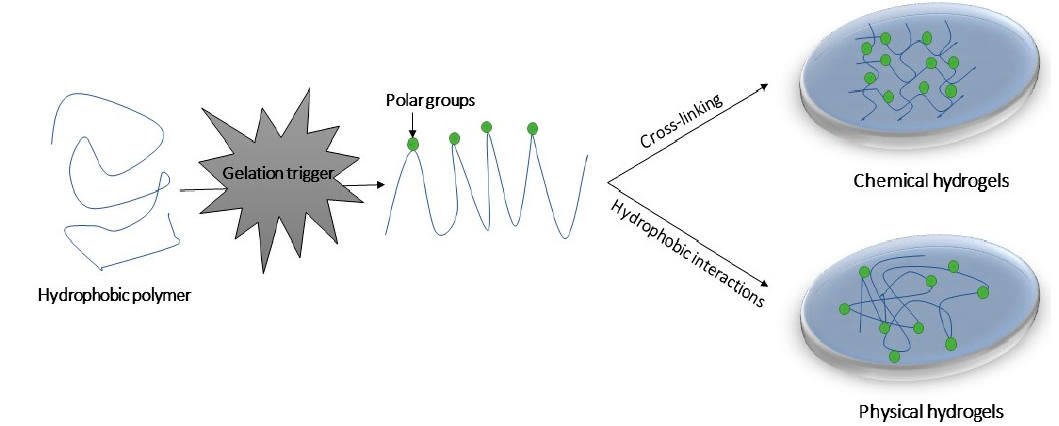
Figure 1. Chemical and physical hydrogels representation.